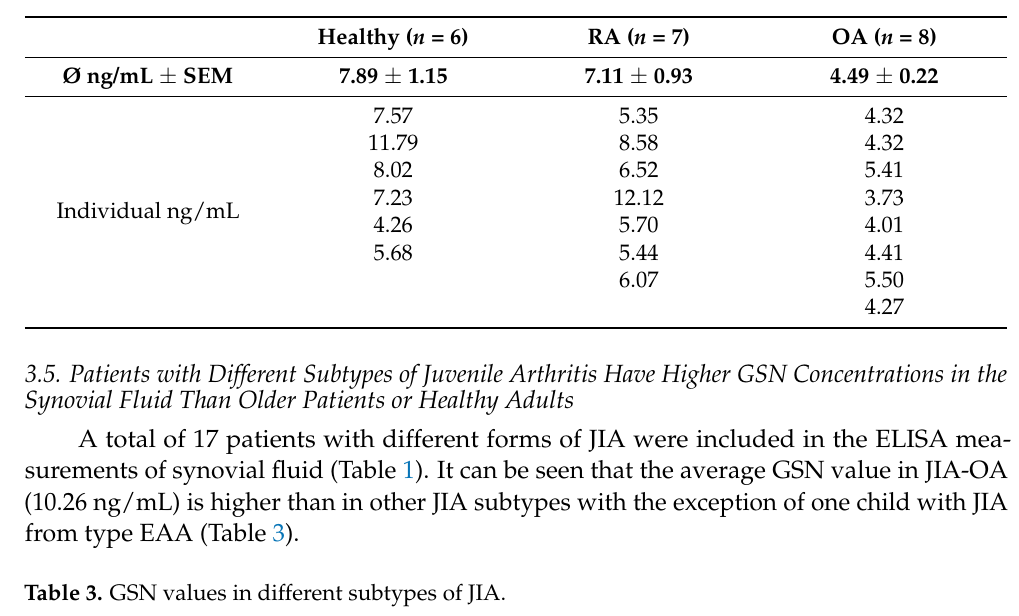
Table 2. Gelsolin concentration in synovial fluids.